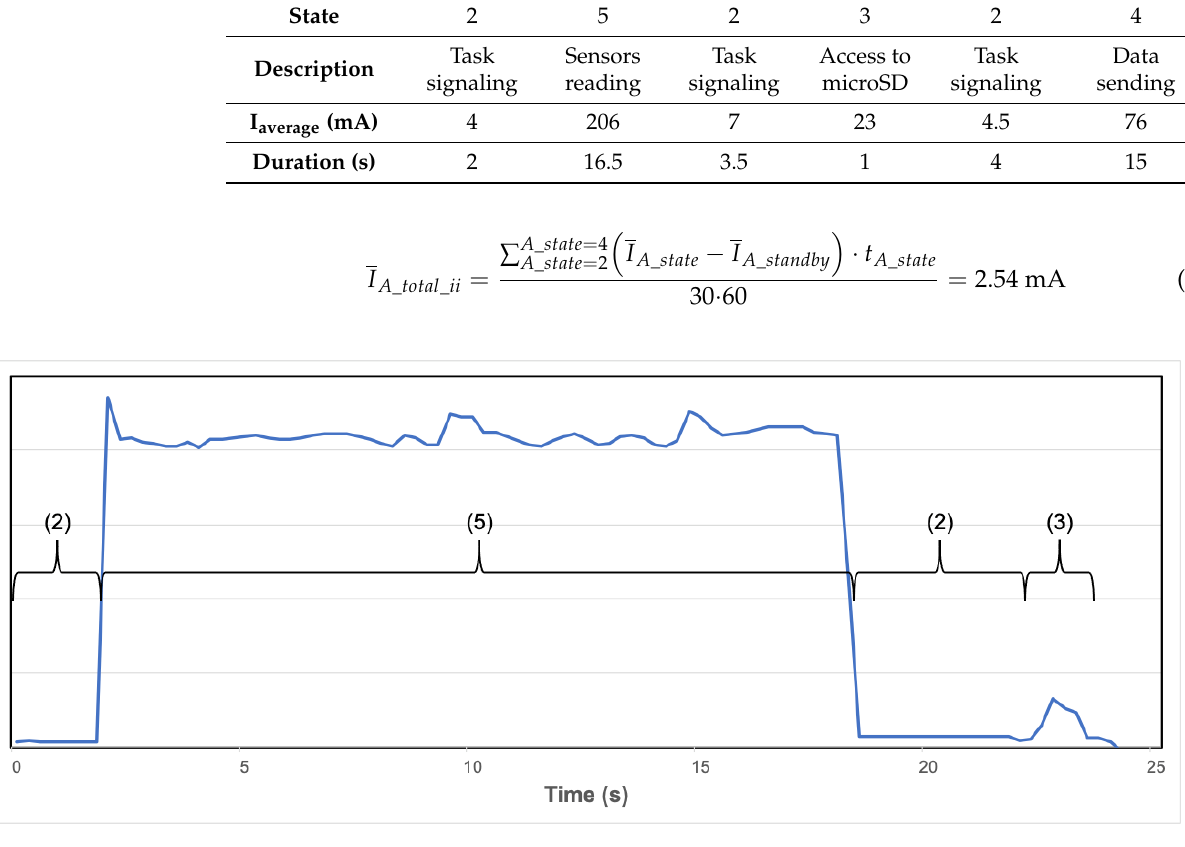
Figure 6. Node A—mode (ii): Sensor reading with data sending (every 30 min). Table 4. Description of functional states of node A—mode (ii).